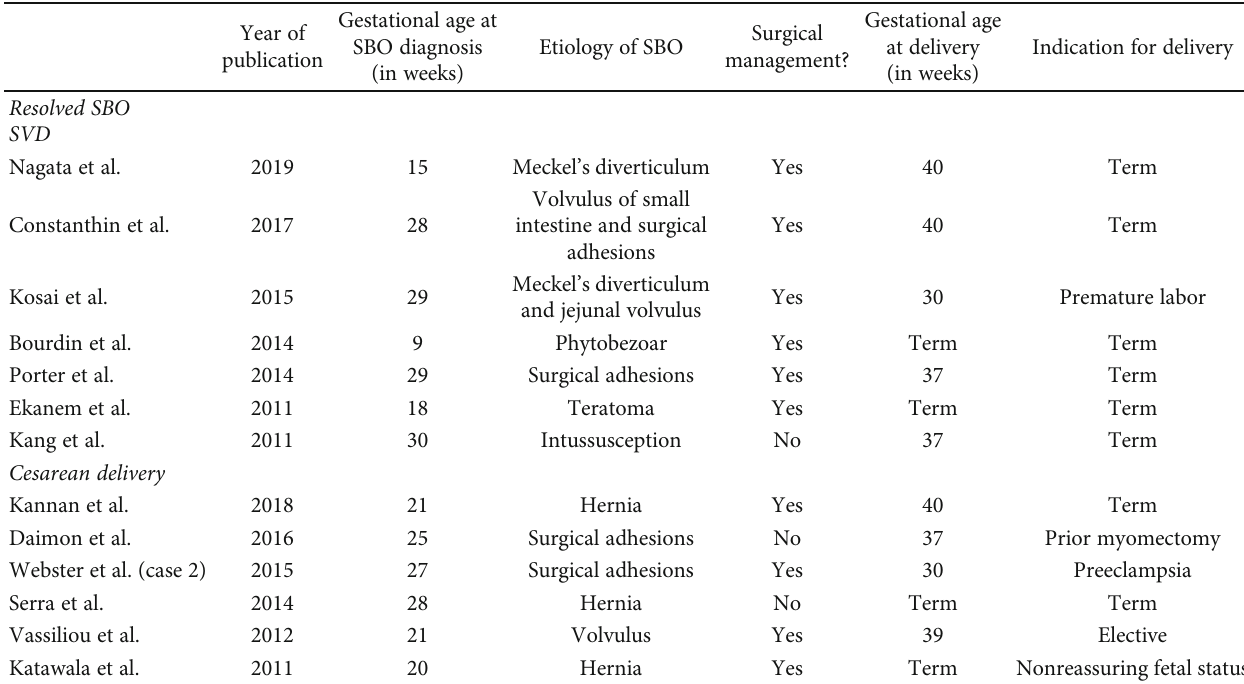
Table 2: Summary of cases with delivery following resolution of small bowel obstruction from 2010 to